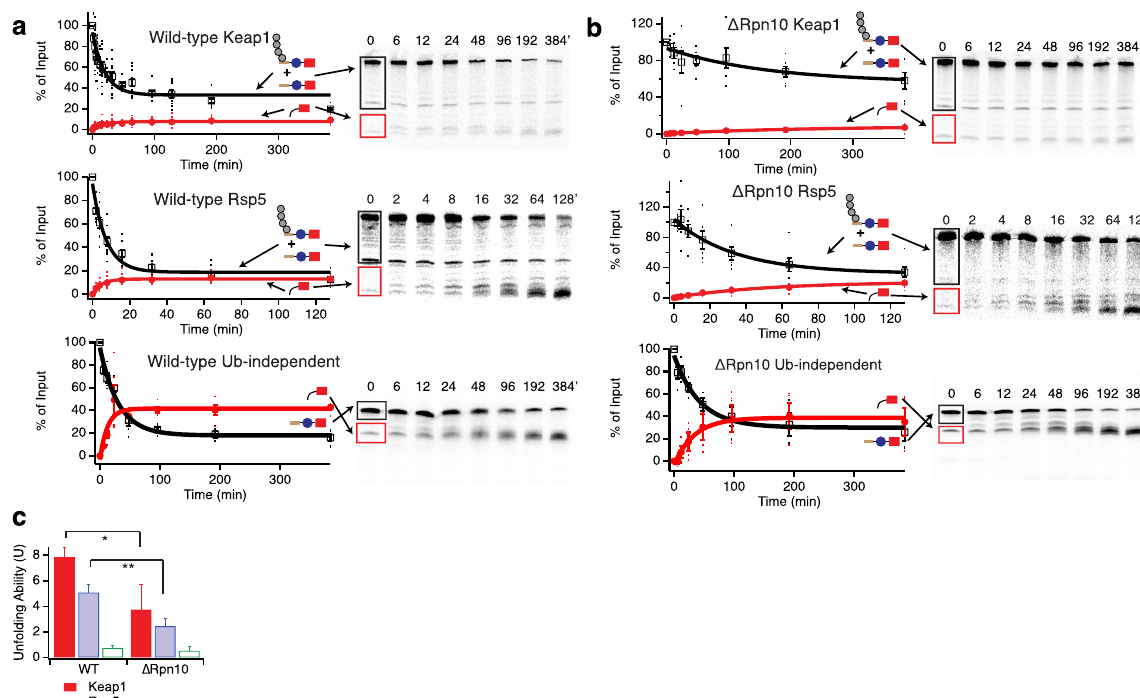
Figure 3. Unfolding abilities of wild-type versus ∆ Rpn10 proteasomes. ( a , b ) Degradation of trace radiolabeled Keap1- or Rsp5-ubiquitinated substrate or ubiquitin-independent substrate (yO44-Barnase-DHFR-His) with a destabilized barnase domain by 100 nM wild-type ( a ) or ∆ Rpn10 ( b ) proteasome. Black box shows region of the gel containing full-length protein with or without ubiquitination. Red box shows the region of the gel containing the DHFR fragment. The amounts of full-length protein (open squares) and DHFR fragment (red circles) are shown as a percentage of the ubiquitinated full-length substrate presented to the proteasome at the beginning of the reaction (or the full-length protein for the ubiquitin-independent substrate); the full-length protein is quantified as the sum of ubiquitinated and non-ubiquitinated full-length species so any deubiquitination is not misinterpreted as degradation. Dots are results from individual experiments, and error bars represent the SEM of 6–22 experiments. Curves are global fits to single exponentials. Sample gels are shown on the right. ( c ) Unfolding abilities (U) calculated from the curve fits shown in ( a , b ). Error bars are the SEM propagated from curve fitting the collected data sets. Two-tailed t-tests were used to determine significant differences from wild-type with an α of 0.05. * Indicates p = 0.05, ** indicates p = 0.004 relative to wild-type. Full-length gels are presented in Supplementary Fig.